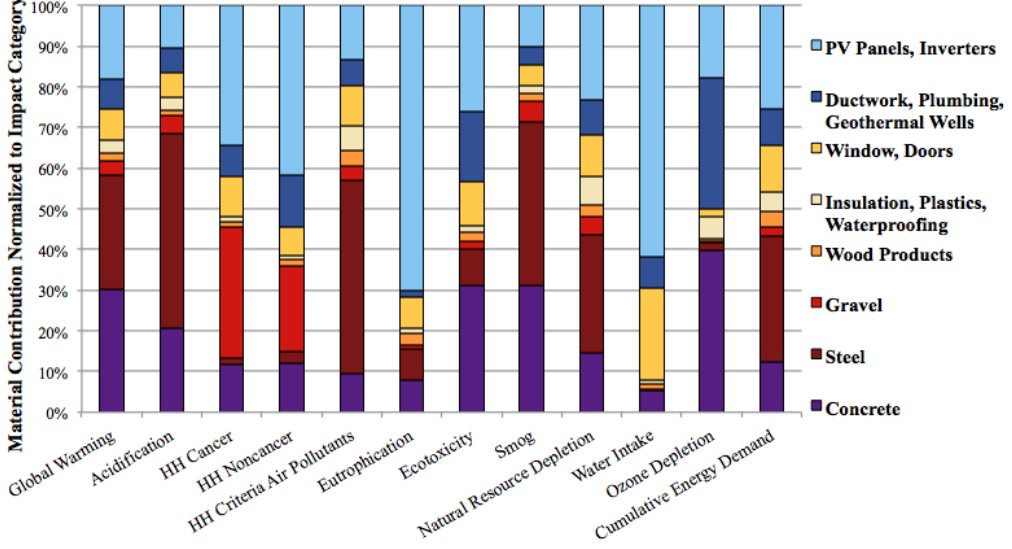
Figure 3. Life cycle environmental impacts of building materials by material type for net-zero energy building (PV =